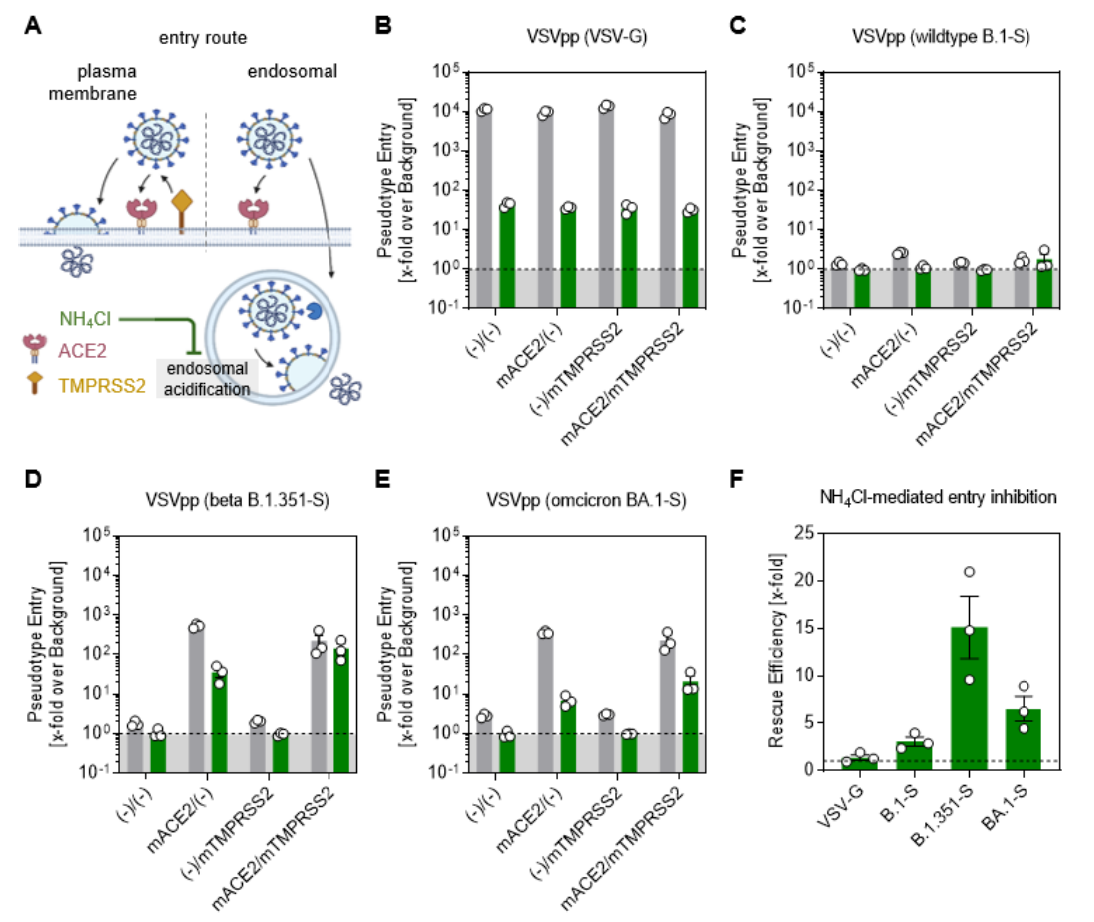
Figure 5. Omicron spike-driven cell entry is less dependent on TMPRSS2 than Beta. ( A ) Simplified representation of the two putative entry routes for SARS-CoV-2 via plasma membrane fusion or via the endosomal pathway. In both routes, SARS-CoV-2 is recognized by ACE2 and either proteolytically cleaved in the presence of TMPRSS2 to enter the cell via membrane fusion. In the absence of TMPRSS2, the virus is engulfed endosomally and, after proteolytic cleavage by cathepsin L, membrane fusion of the host endosome with the viral membrane is induced. Ammonium chloride (NH 4 Cl) prevents endosomal acidification, making the endosomal entry pathway inefficient for the virus entry. BHK21 cells transiently expressing murine (m)ACE2 and/or (m)TMPRSS2 were treated for 2 h with DMSO as control (grey bar) or 50 mM NH 4 Cl (green bar). Furthermore, they were inoculated with particles pseudotyped with ( B ) the glycoprotein, ( C ) SARS-2-S of wild-type B.1 ( D ) Beta B 1.351-S and ( E ) Omicron BA.1-S. At 16 h after inoculation, the SARS-2-S-related cell entry of the viral pseudotypes was analyzed by measuring the activity of luciferase activity encoded by the virus in cell lysates. ( F ) The calculated rescue efficiency represented by the fold difference in NH 4 Cl-mediated entry inhibition between mACE2/( − ) and mACE2/mTMPRSS2 groups. (Figure 5A Created with